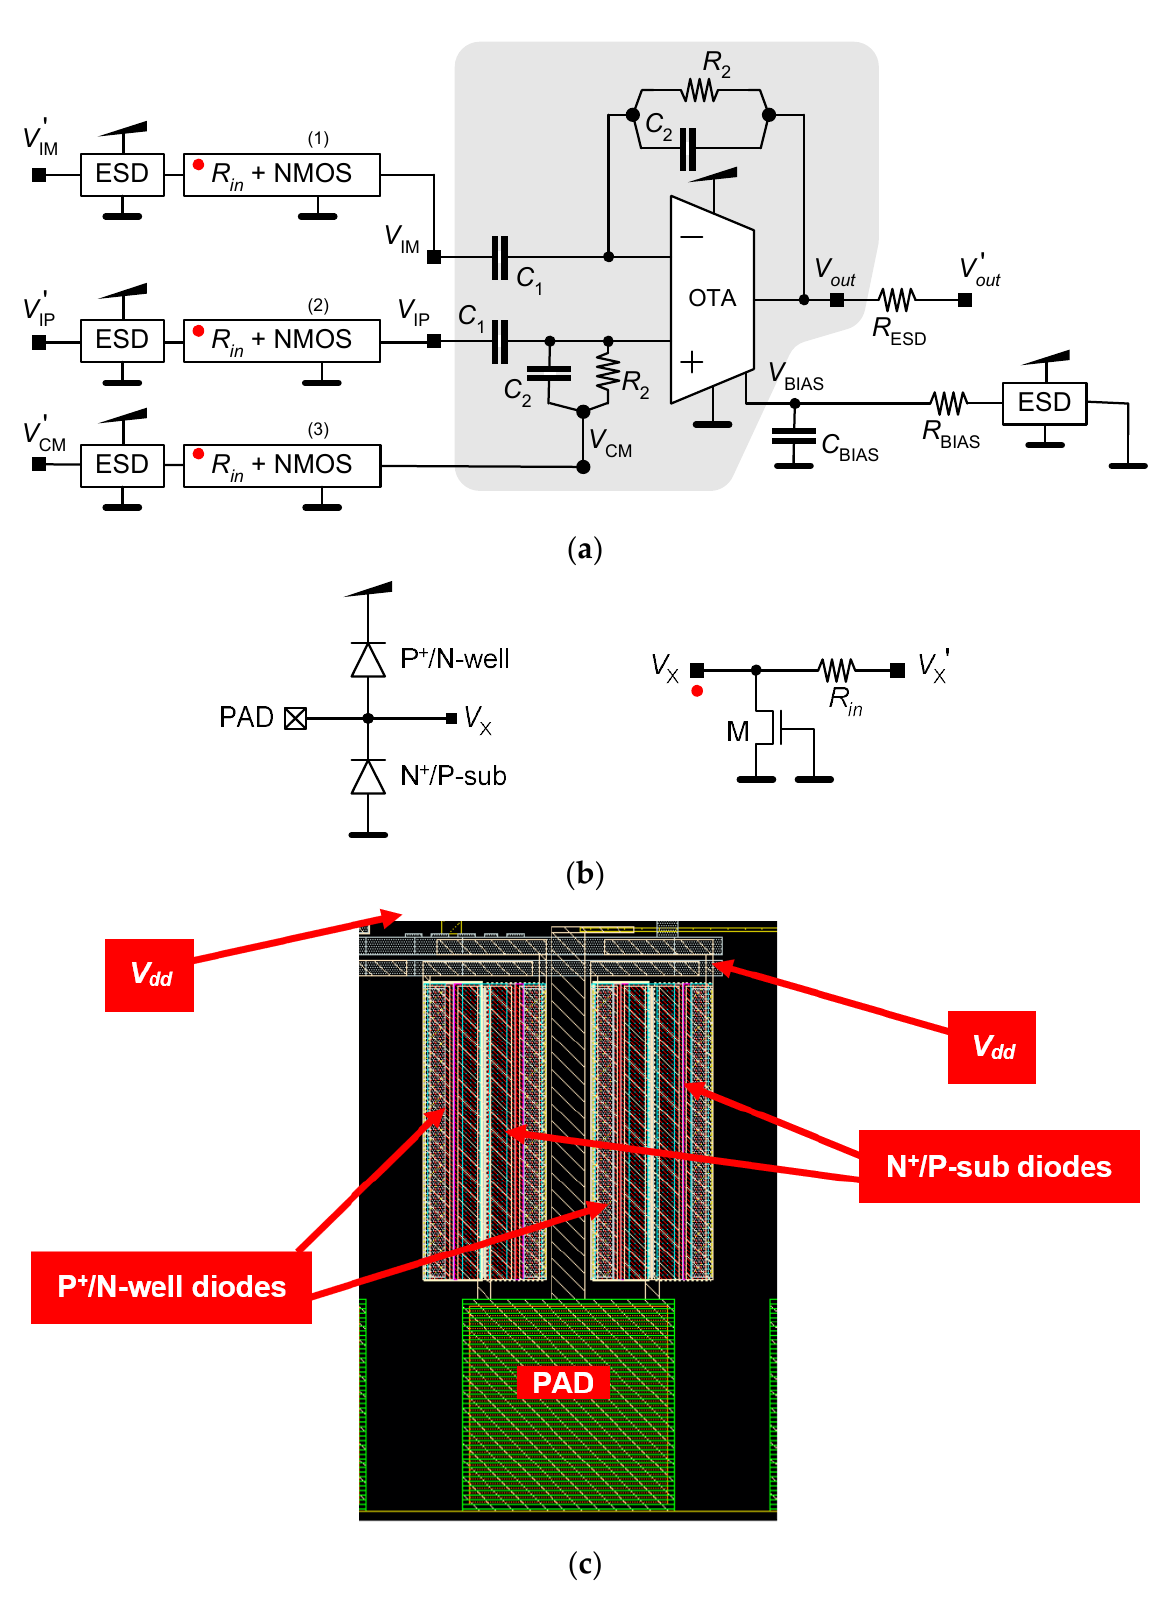
Figure 4. ( a ) Illustration of how the ESD protections, input resistance R in with NMOS and output resistances R ESD are connected to the low-noise amplifier. ( b ) Schematics of ESD protections (on left) and resistance with NMOS (on right). ( c ) Layout of the ESD protections [56].